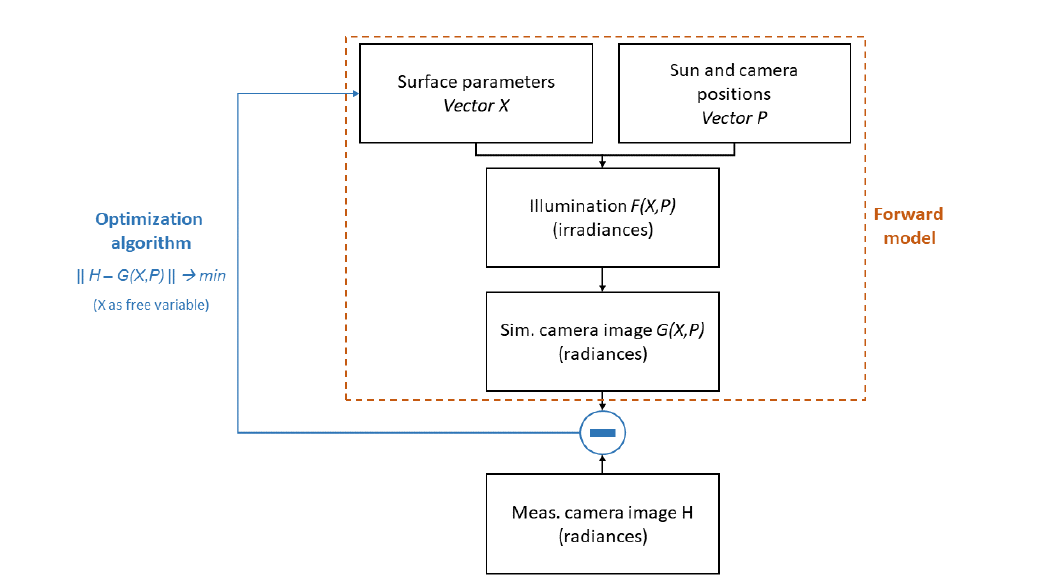
Figure 23. Algorithmic scheme for parameter estimation. The inversion should be done with a large amount of images to increase. The overall method is modular, that is, e.g., the optimization algorithm can be replaced by another one. In addition, the tool for generation of illumination conditions as well as that for camera images can be replaced by another one, as long as all interfaces are